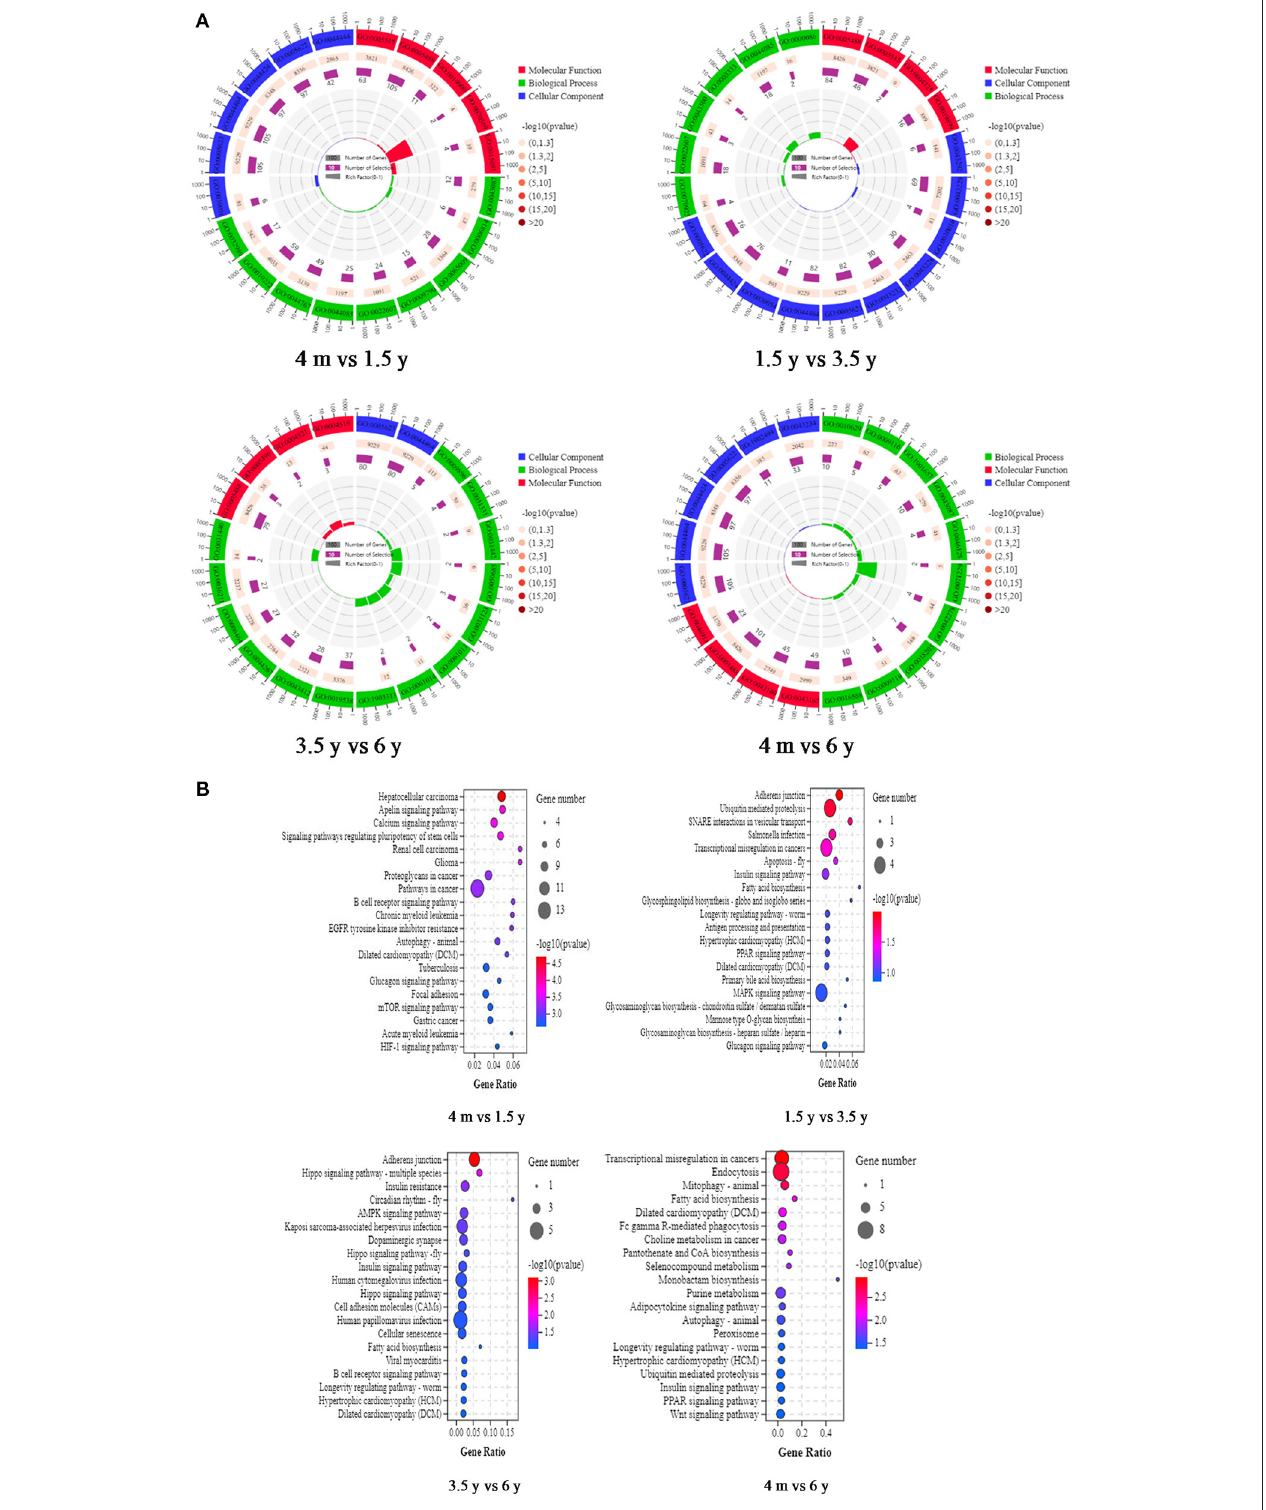
FIGURE 4 | GO functional annotation and KEGG enrichment analysis of source genes of DE circRNAs. (A) Representative of the GO enrichment circle diagram in four contiguous period transcriptome comparative groups (4m vs. 1.5 y, 1.5 y vs. 3.5 y, 3.5 y vs. 6 y, and 4m vs. 6 y group). Green is biological process (BP). Red is molecular function (MF). Blue is cellular component (CC). (B) Representative KEGG pathway analysis of the source genes of DE circRNAs in 4m vs. 1.5 y, 1.5 y vs. 3.5 y, 3.5 y vs. 6 y, and 4m vs. 6 y group, respectively.